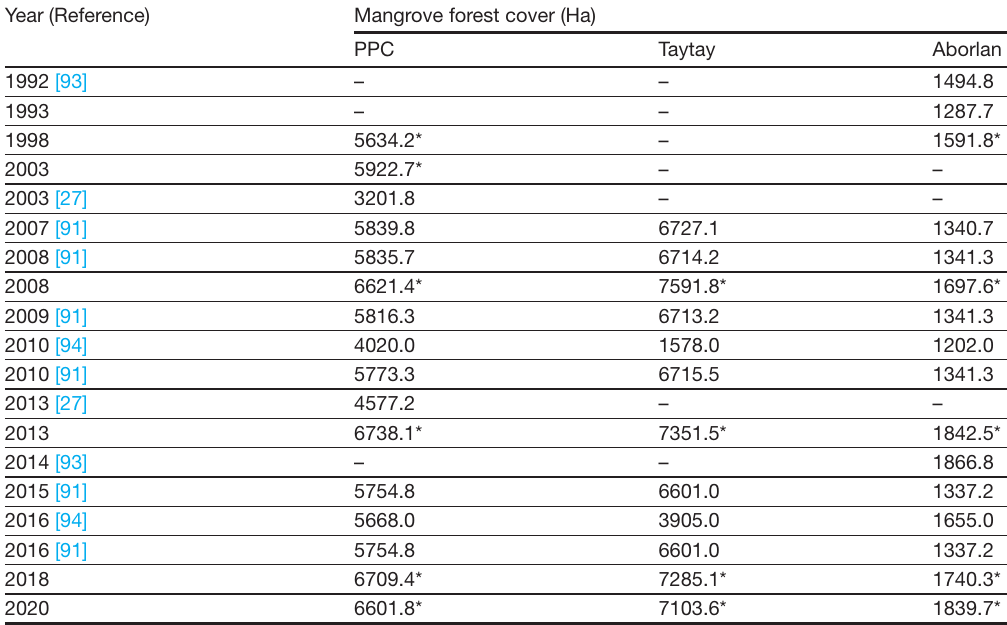
Table 2. Comparison of mangrove forest areas in Taytay, Aborlan and PPC based on the previous estimates and the results of this study Year